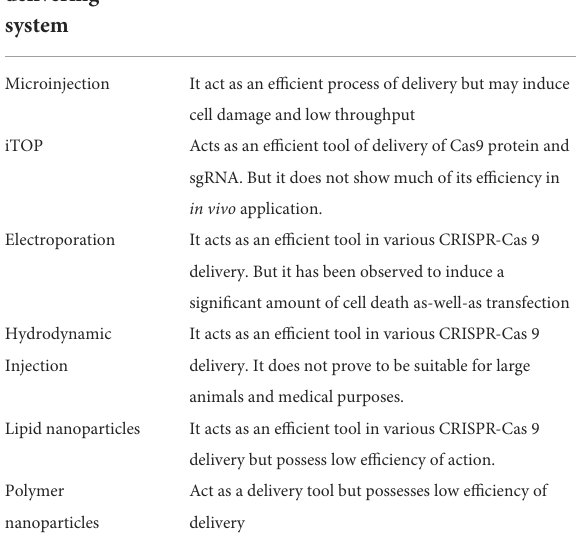
TABLE 1 Various delivery tools for CRISPR-Cas